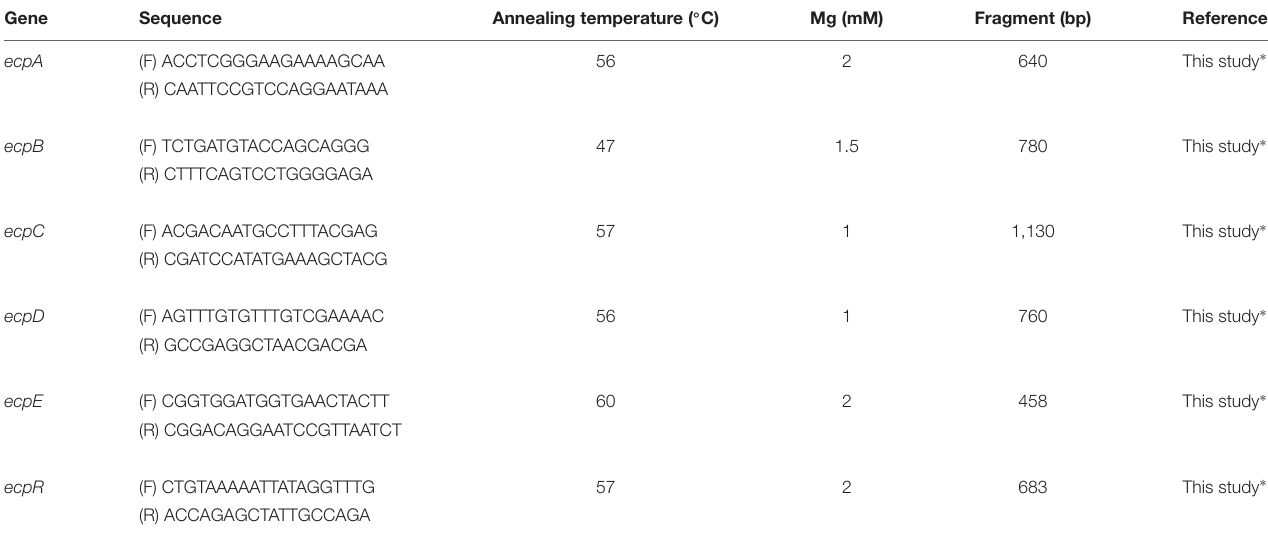
TABLE 1 | Primer sequences of ecp operon and PCR conditions used to study ecp operon.